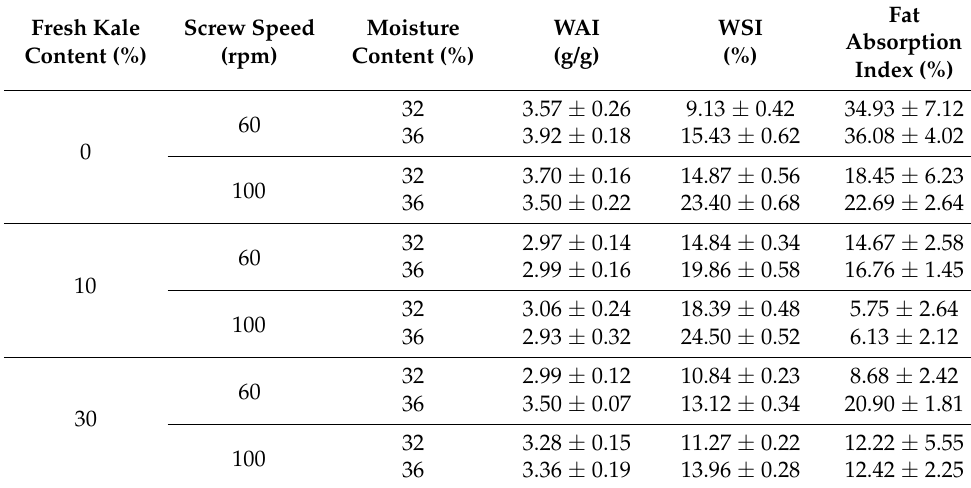
Table 6. Selected physical properties of snack pellets enriched with fresh kale (n = 3, ± SD). Fresh Kale Screw Content (%)